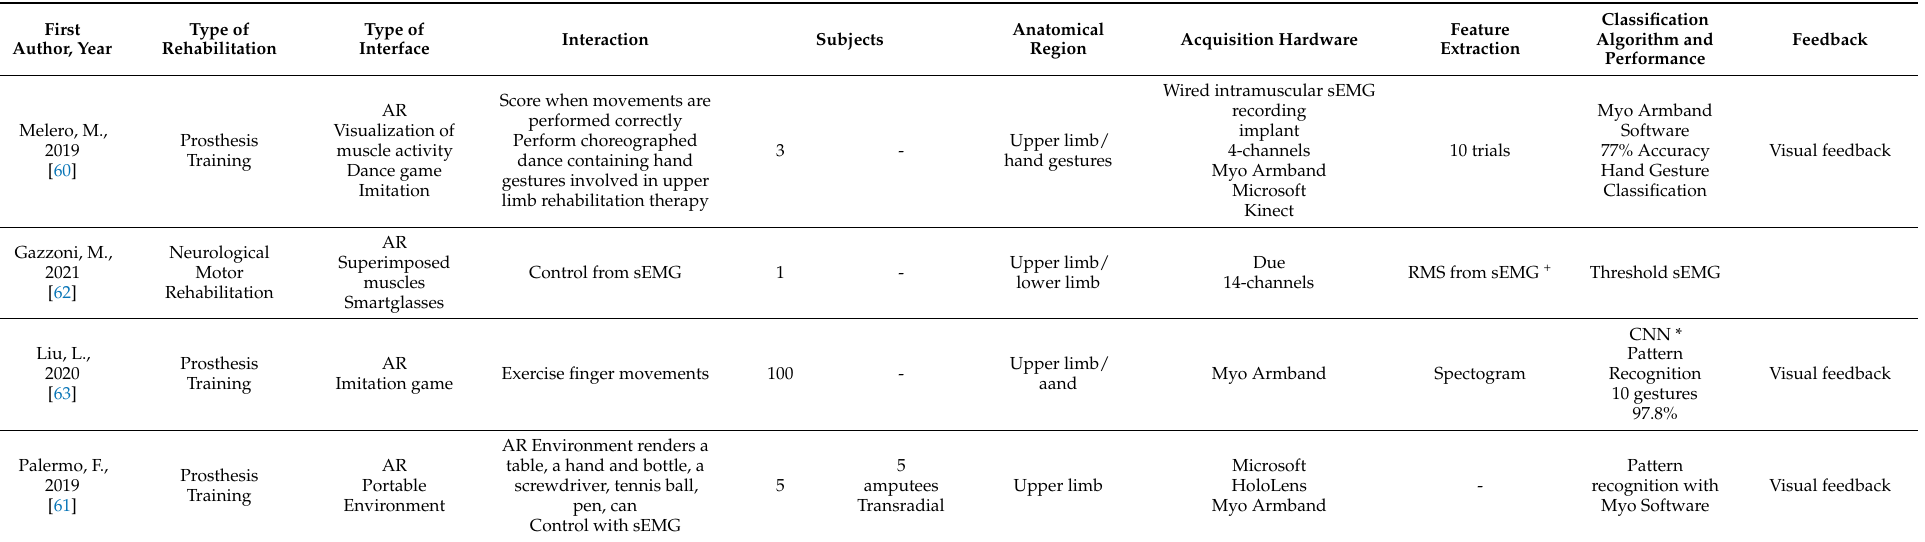
Table 3. AR Interfaces used for motor rehabilitation based on sEMG